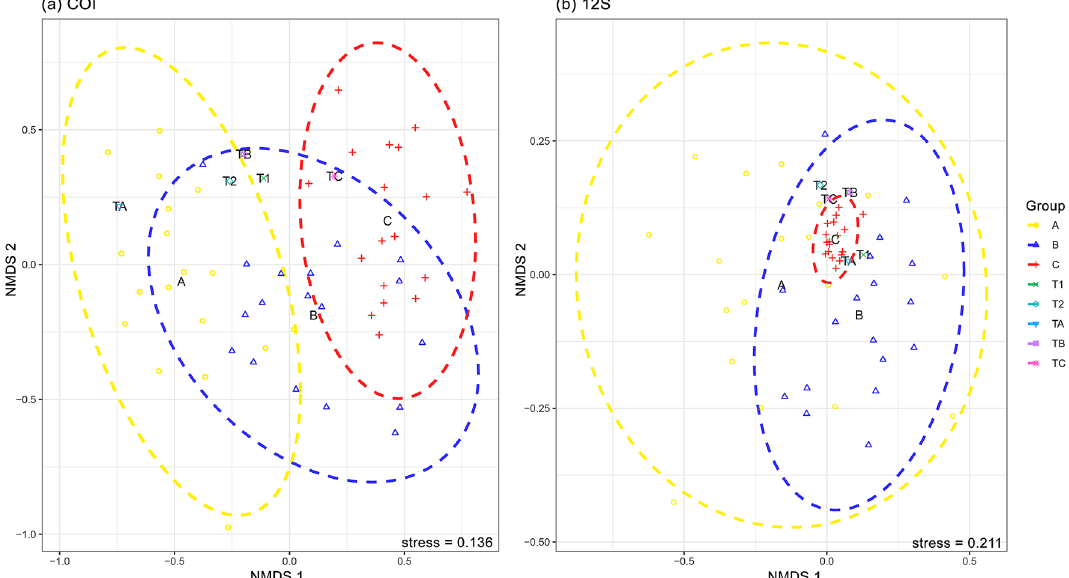
Figure 7. Nonmetric multidimensional scaling (NMDS) ordination of fish community in Merbok Estuary using the Bray–Curtis coefficient for both metabarcoding assays: ( a ) COI assay and ( b ) 12S assay. Different symbols denote individual samples analysed and the community clusterings are colour-coded (see legend). The ordination stress value is indicated at the bottom of each